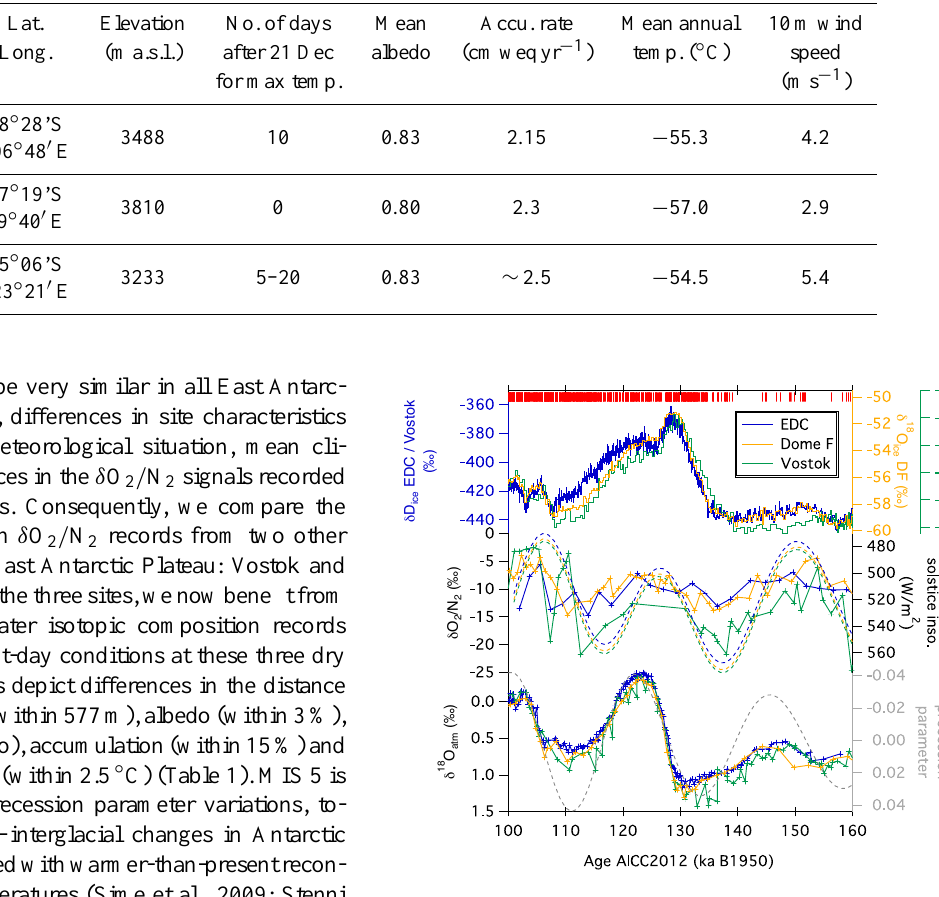
Figure 3. Inter-comparison of Vostok (green), Dome F (yellow) and EDC (blue) data covering MIS 5 presented on AICC2012 (Bazin et al., 2013; Veres et al., 2013), using the volcanic matching between Dome F and EDC published by (Fujita et al., 2015). Top: water isotopic composition (Vostok δ 18 O ice : Petit et al. (1999), Dome F δ 18 O ice : Kawamura et al. (2007), EDC δ D: Jouzel et al., 2007). Middle: δ O 2 / N 2 records and local summer solstice insolation at each site (Suwa and Bender, 2008b; Kawamura et al., 2007, this study). Bottom: δ 18 O atm and precession parameter shifted by 5ka (Suwa and Bender, 2008b; Kawamura et al., 2007; Landais et al., 2013, this